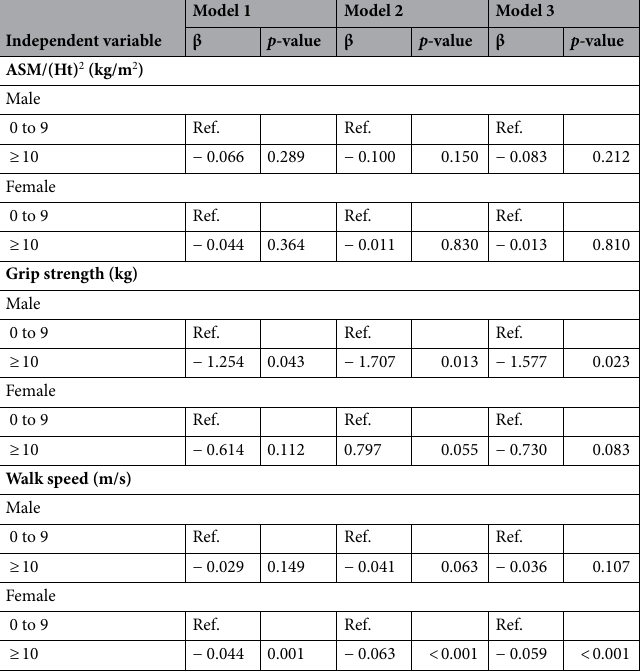
Table 4. Linear association between the number of tooth loss and ASM/Ht 2 , grip strength, walk speed. Model 1: adjusted for age, BMI, district. Model 2: adjusted for age, BMI, district, IPAQ, monthly income, education, smoking, drinking, denture status. Model 3: adjusted for age, BMI, district, IPAQ, monthly income, education, smoking, drinking, denture status, depression, nutrition status, hypertension,